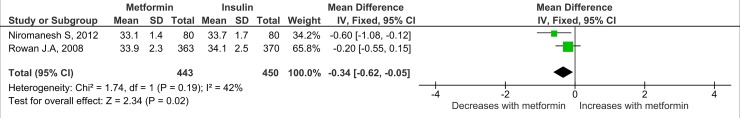
Neonatal chest circumference.Expressed as mean difference (fixed effects model) and 95% CI. IV, mean difference.